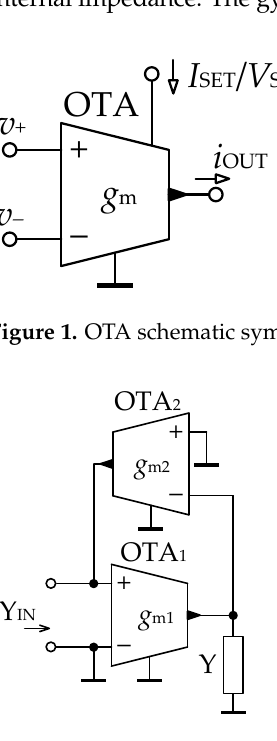
Figure 2. Gyrator with two OTAs.